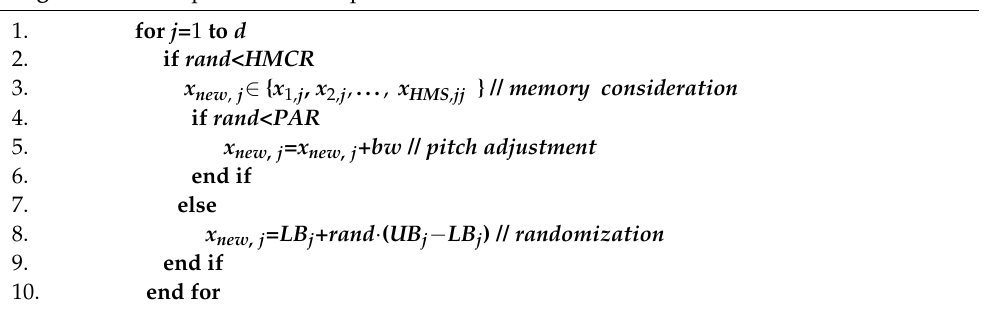
Algorithm 1. The procedure of improvisation in